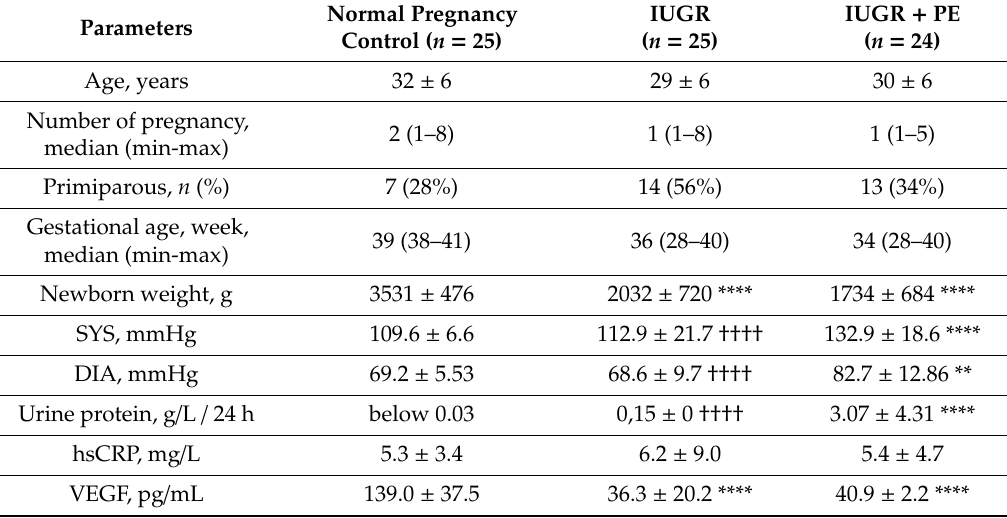
Table 1. Clinical and biochemical characteristic of study subjects. The data were interpreted with repeated measures analysis of variance (one-way ANOVA or Kruskal–Wallis) using a post hoc test for with intrauterine growth restriction of the fetus, IUGR + PE—pregnancy complicated with intrauterine growth restriction and preeclampsia, SYS—systolic blood pressure, DIA—diastolic blood pressure, hsCRP—high-sensitivity C-reactive protein, VEGF—vascular endothelial growth